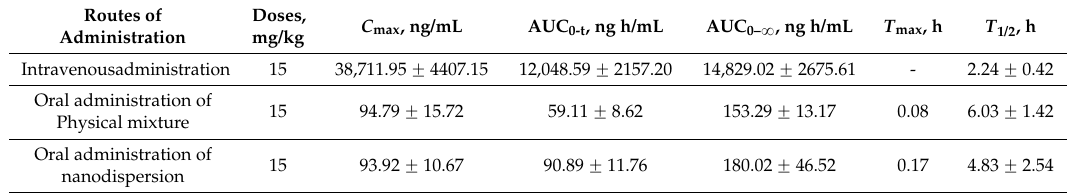
Table 4. The main pharmacokinetic parameters of taxifolin after intravenous administration and oral administration of taxifolin and its nanodispersion at a dose of 15 mg/kg.